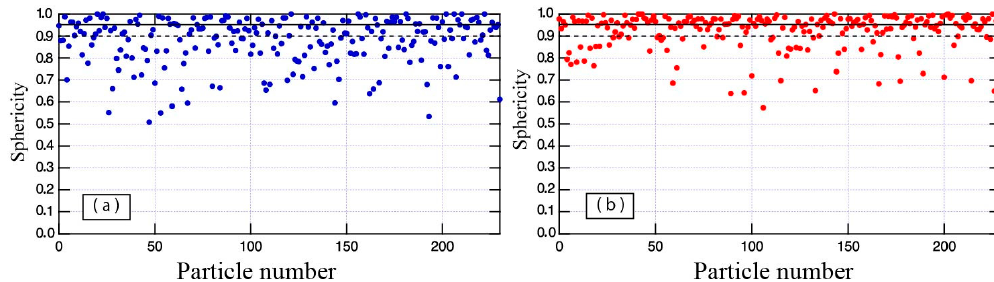
Figure 4. Sphericity plots of ( a ) raw powder and ( b ) plasma-treated powder.